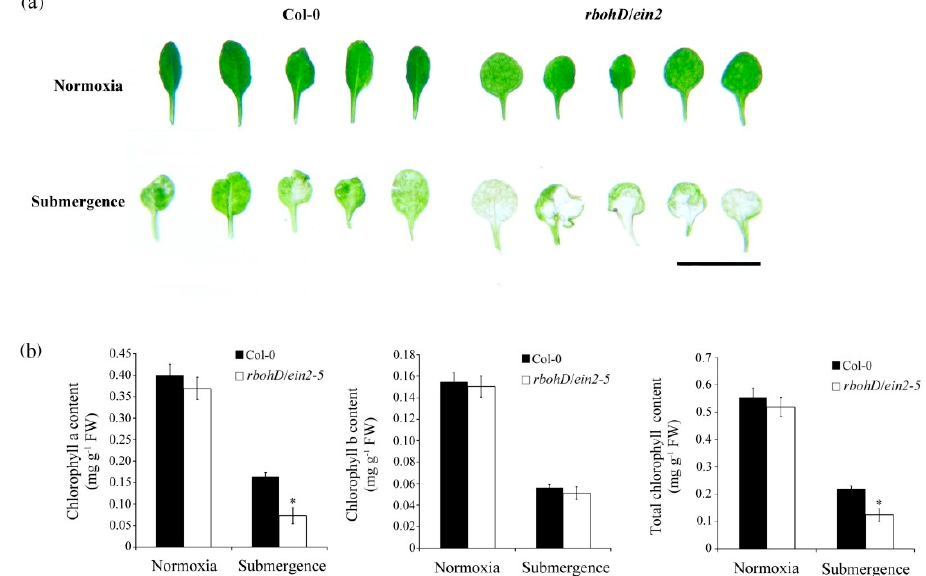
Figure 5. Chlorophyll content of wild-type plants and rbohD / ein2-5 double mutants after submergence stress. ( a ) Phenotype of 7-day-old wild-type plants (Col-0) and double mutant rbohD / ein2-5 leaves after treatment under normoxic conditions and submerged conditions for 12 d. Bar = 1 cm. ( b ) Contents of chlorophyll a, b, and total chlorophyll of 7-day-old seedlings after treatment under normoxic conditions and submerged conditions for 12 d. Values represent means ± SD from three biologically independent experiments. * p < 0.05, versus wild-type (Student’s t test).